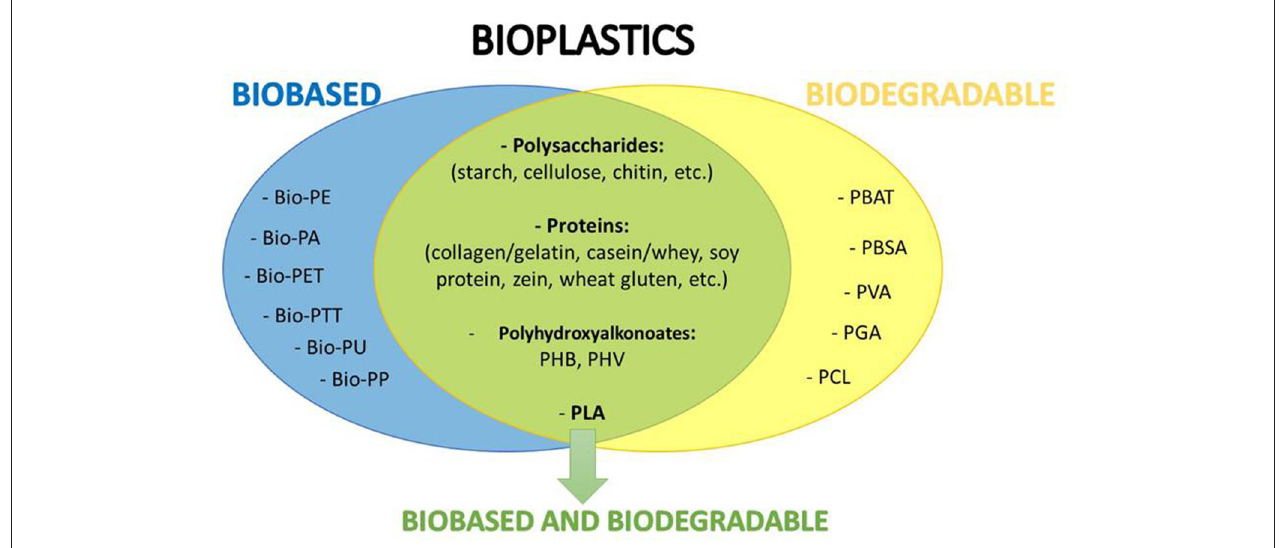
FIGURE 2 | Classification of bioplastics into three main groups: ( (cid:4) ) biobased but non-biodegradable polymers; ( (cid:4) ) plastics that are biodegradable and based on fossil resources, and ( (cid:4) ) polymers that are both biobased and biodegradable.